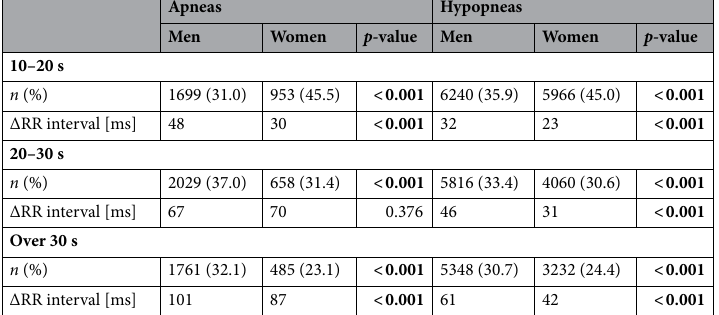
Table 4. The median differences between within-event (i.e. during a respiratory event) and post-event (i.e. within a 15-s segment following a respiratory event) RR intervals in different respiratory event duration groups. p -values presented in the table denote the statistical significance of difference in the median RR interval between men and women (the Mann–Whitney U test for continuous and the χ 2 -test for discrete variables). p -values denoting statistically significant differences ( p < 0.01) are bolded. All presented median differences between within- and post-event RR intervals were significant ( p < 0.001) according to Wilcoxon signed-rank test and all the differences between event duration derived groups were significant ( p < 0.001) according to the Mann–Whitney U test. ΔRR interval the median differences between within- and post-event RR intervals, n the number of events used to determine the